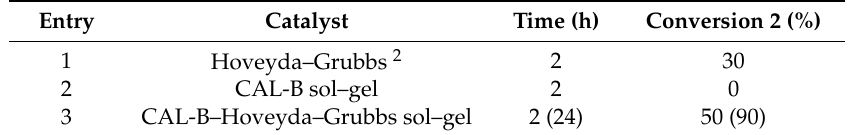
Table 5. Enzyme–Hoveyda–Grubbs second-generation catalysts in ring-closing metathesis (RCM) of 1 in 2-( N -morpholino)ethanesulfonic acid (MES) buffer at pH 6 and 200 mM NaCl and 25 ◦ C 1 .